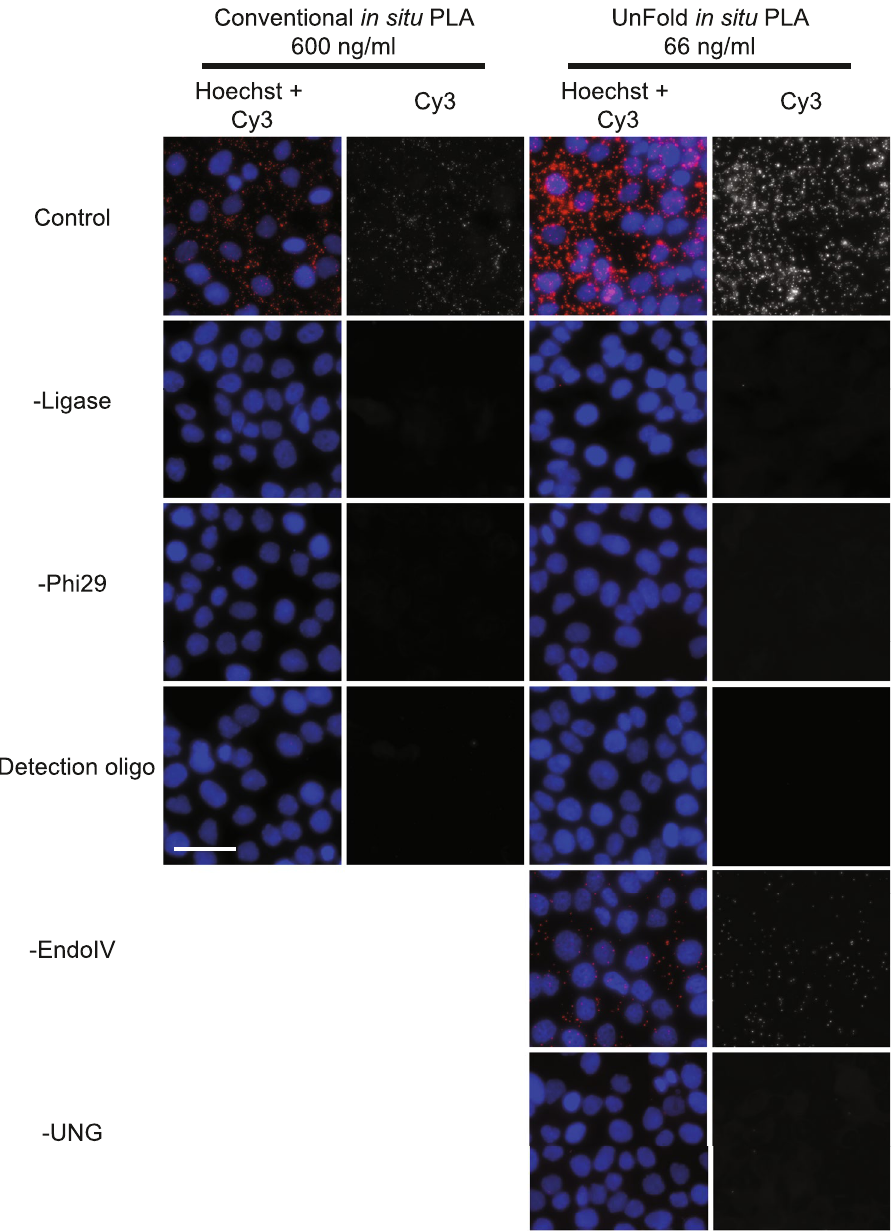
Figure 4. Image panel of HaCat cells showing detection of β -catenin/E-cadherin interaction or different technical controls, omitting enzymes. For the top image row, both of the primary antibodies and the PLA probes were included, revealing the characteristic staining pattern of β -catenin/E-cadherin interactions. The remaining rows in the panel show the effect of removing enzymes or detection oligonucleotides as indicated in the figure. All signals were stained with Cy3 (Red in merge images or in grayscale) and the nuclei were stained with Hoechst 33342 (Blue). Scale bar (white) = 50 μ